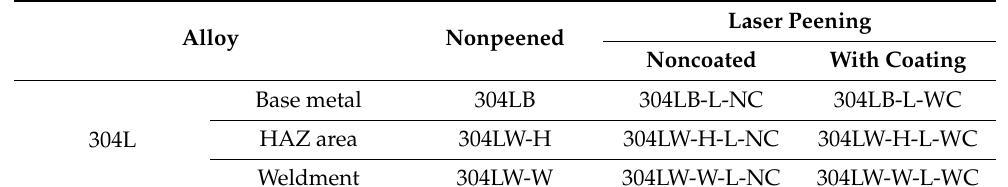
Table 1. Chemical composition of 304L stainless steel and filler metal (wt %).